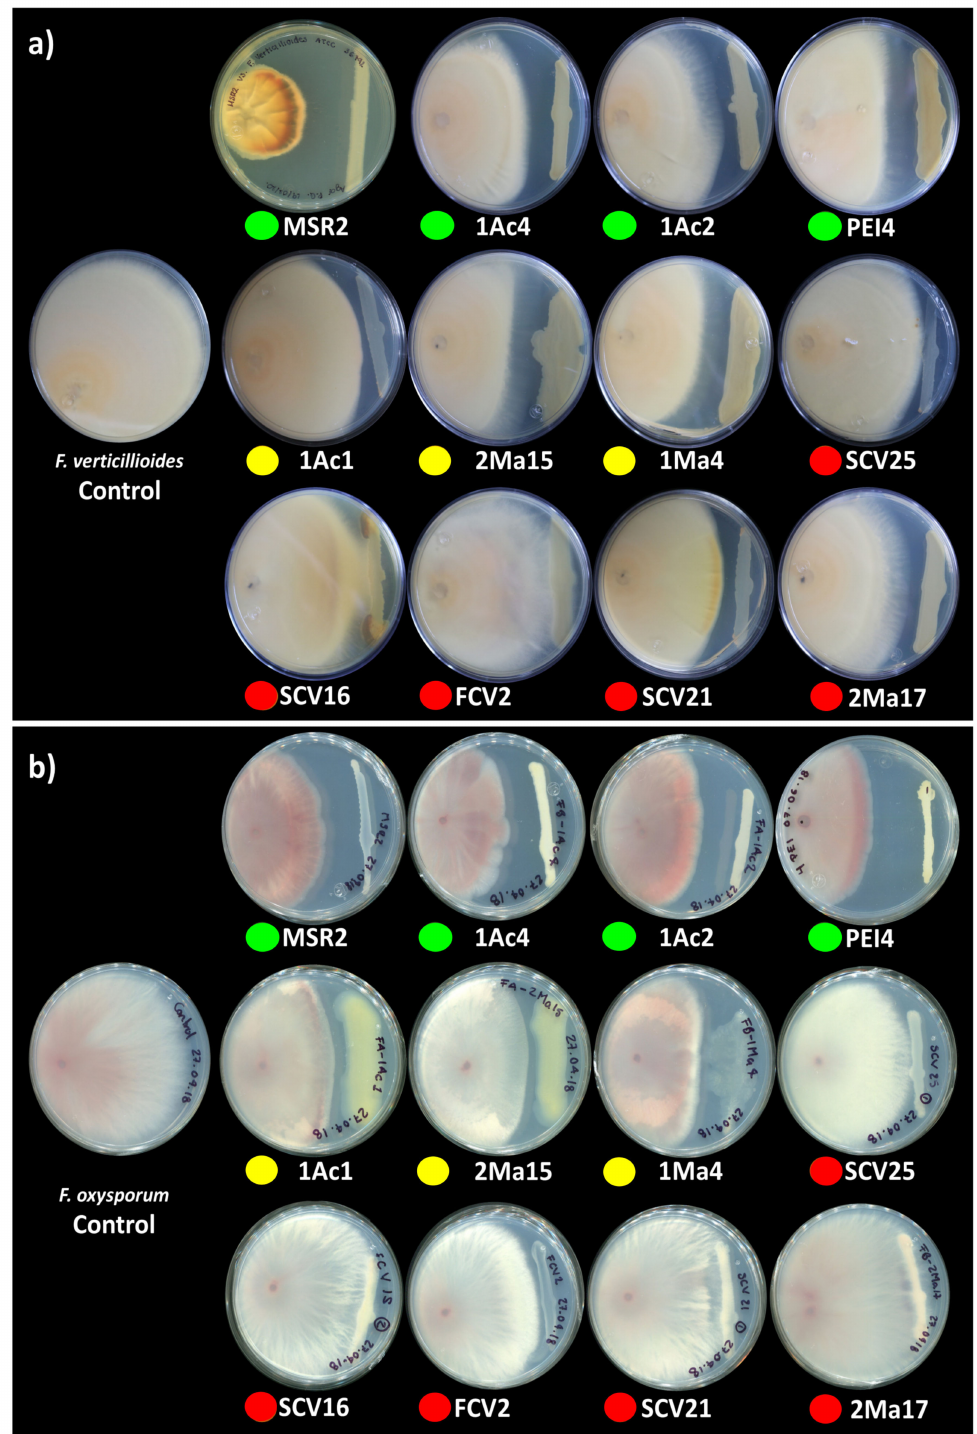
Figure 2. Antagonism of rhizosphere Burkholderia sensu lato strains against phytopathogenic Fusarium . Antagonism vs. ( a ) F. verticillioides MF-257 and ( b ) F. oxysporum f. sp. radicis-lycopersici was determined by the capacity of rhizosphere Burkholderia strains to inhibit their radial hyphal growth when placed in direct confrontation. The single plates in the left end of the image correspond to the negative controls. The colored circles below the plates represent the different Burkholderia sensu lato groups: green = Clade I; yellow = Clade II; and orange-red = Clade III. The results shown are representative of experiments that were performed with five ( F. verticillioides ) and three ( F. oxysporum ) replicates per bacterial